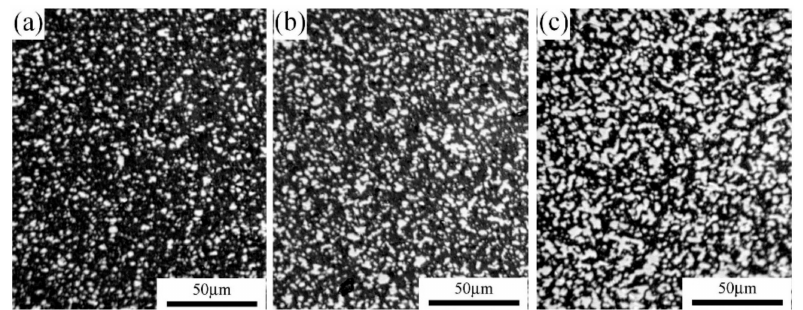
Figure 4. Optical microstructure of the Si 3 N 4 –MoSi 2 composites of ( a ) Si 3 N 4 -30 wt % MoSi 2 ,